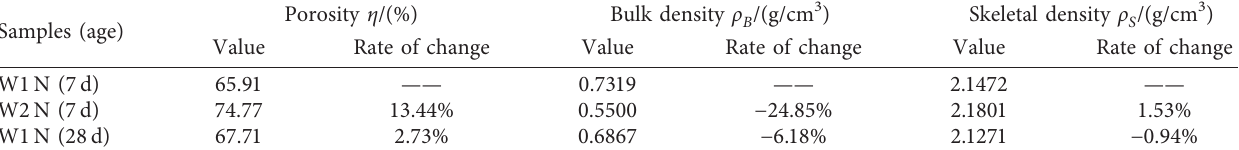
Table 3: Porosity and density of NCG concretion. The data of “the rate of change” is the rate of change relative to W1N (7d). Samples (age)